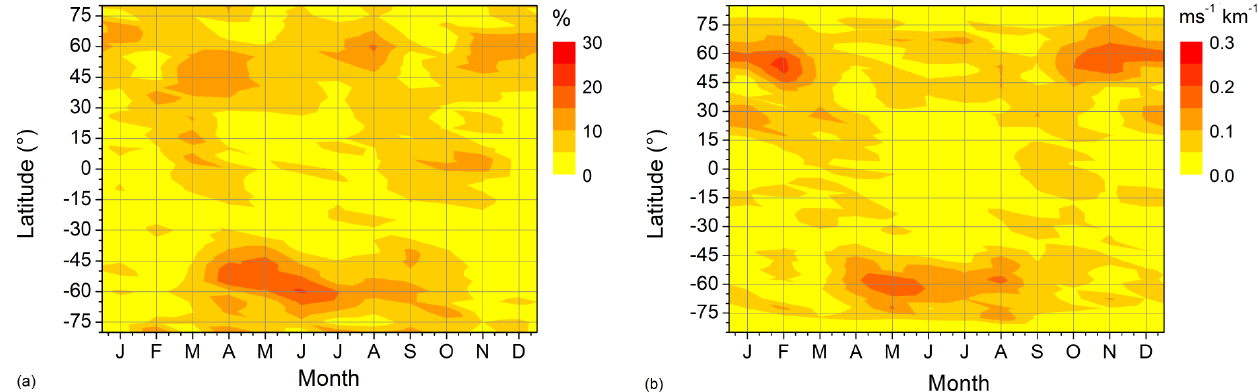
Figure 7. (a) 2007–2016 mean monthly mean QDT Es relative amplitudes at 101km. (b) MUAM zonal wind shear at the nearest model level at 100 .